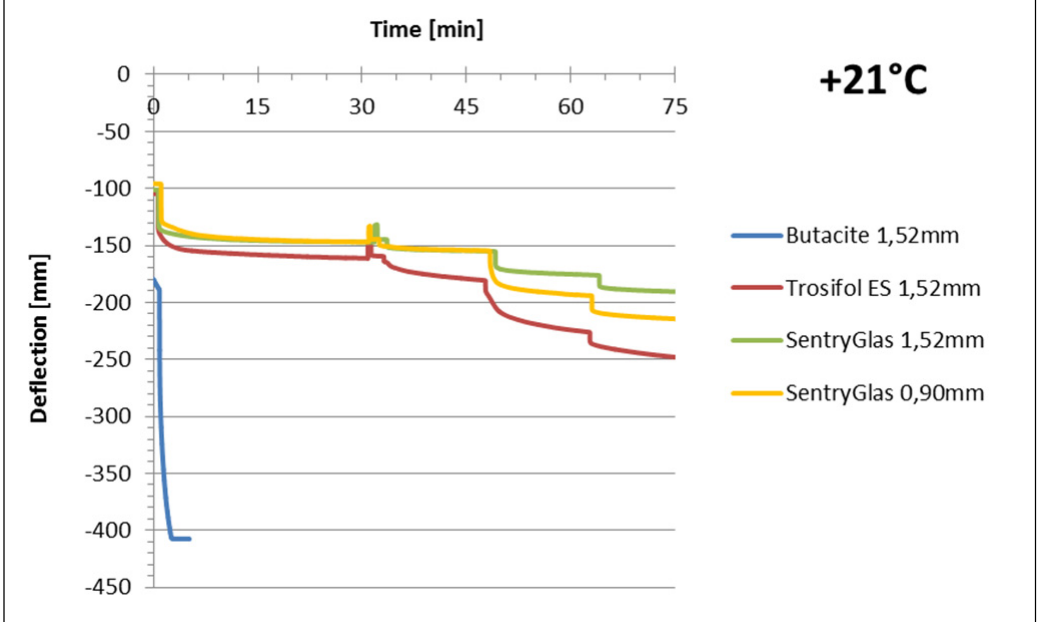
Fig. 15 Deflection Vs Time Measurements @ +20°C Butacite® = Standard PVB, Trosifol® ES = Stiff PVB, SentryGlas® =